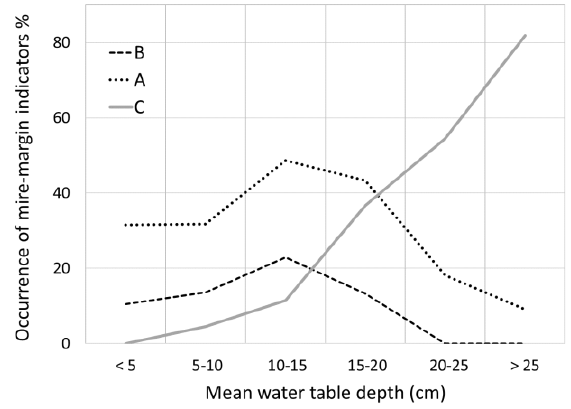
Figure 8. The relationship between mean water table depth in the large sample plots and the occurrence of mire margin indicators (probability that at least 10 % of species are indicators of